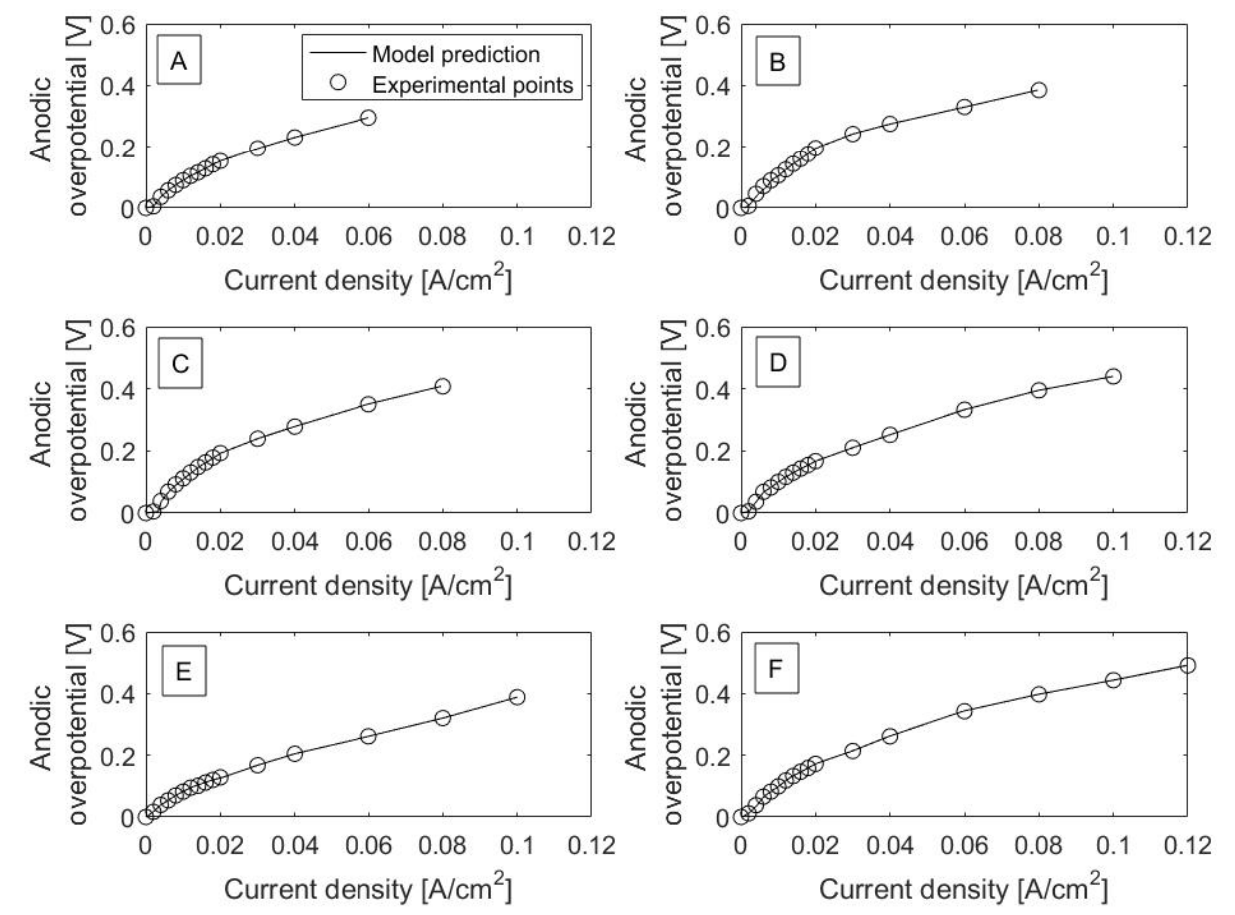
Figure 1. Polarization curves for Pt–Sn catalysts. ( A ) Pt 9 Sn; ( B ) Pt 4 Sn; ( C ) Pt 3 Sn; ( D ) Pt 2 Sn; ( E ) PtSn 3 ; ( F ) ETEK. Table 1. Fitted reaction rate constants and regression parameters. Figure 2 presents the fitted surface coverage fraction distributions for each catalyst. The lines in the graph do not represent a model fit and are visual guides only. Surface coverage fractions were fitted for each adsorbed species at each overpotential value from the experimental data points.